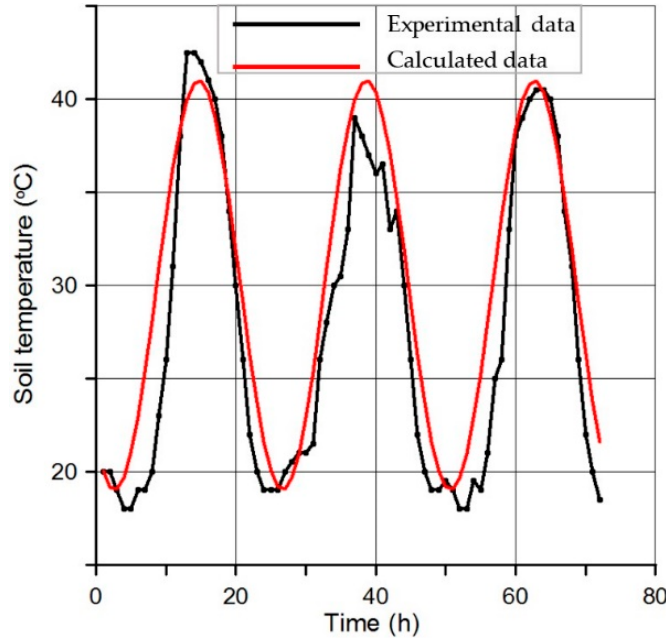
Figure 3. Experimental and calculated data on soil temperature variation.